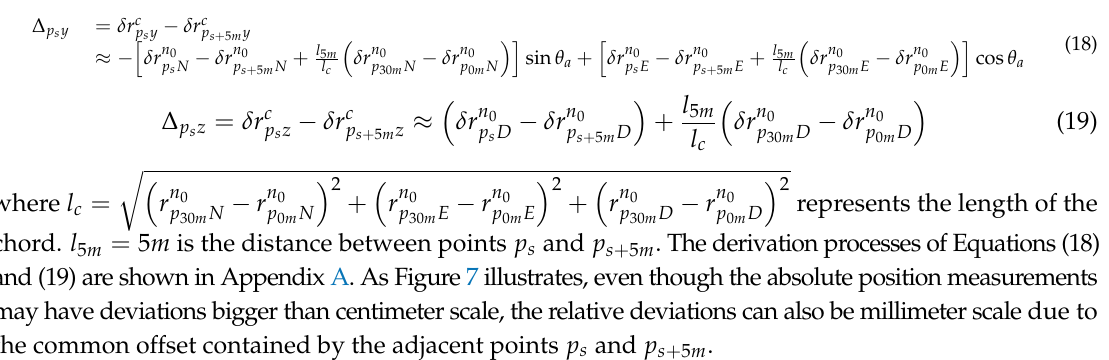
Substituting Equations (16) and (17) into Equation (1) yields the alignment irregularity and the level irregularity. Since gradient of the railway track is very small (25 m/1000 m for the largest gradient) and the turning radius is very large (2000 m) in general, the alignment irregularity and the level irregularity can be simplified by ignoring the small terms as Equations (18) and (19) show: